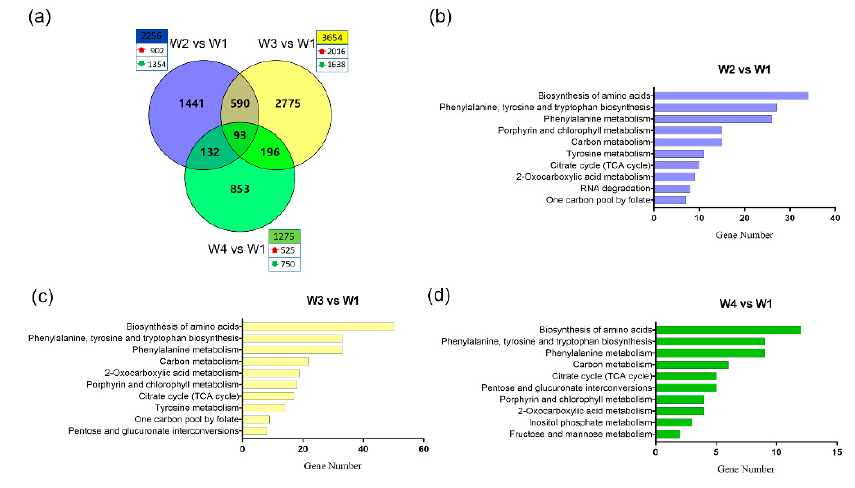
Figure 3. The numbers of di ff erentially expressed genes (DEGs) and significantly enriched Kyoto Encyclopedia of Genes and Genomes (KEGG) pathways. ( a ) Venn diagram showing the share and specific DEG numbers in di ff erent combinations, displayed in the overlapping and non-overlapping regions, respectively. The total numbers of DEGs in W2 vs. W1 (blue circle), W3 vs. W1 (yellow circle), and W4 vs. W1 (green circle) are shown in the first line of the box, including the numbers of upregulated (upward red arrow) and downregulated (downward green arrow) DEGs. Histogram showing the top 10 (ranked by gene number) enriched KEGG pathways in W2 vs. W1 ( b ), W3 vs. W1 ( c ), and W4 vs. W1 ( d ).